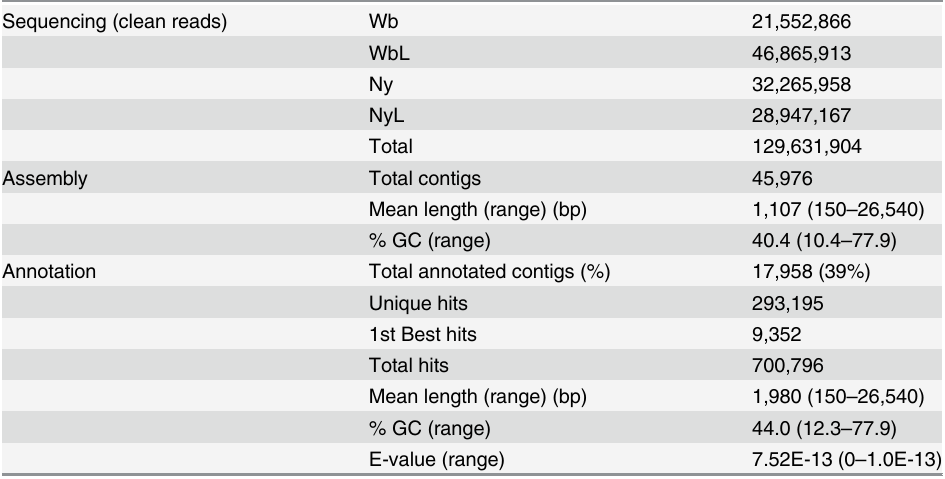
Table 1. Summary of DNA sequencing, assembly, and annotation of Asian citrus psyllid transcript libraries. Sequencing (clean